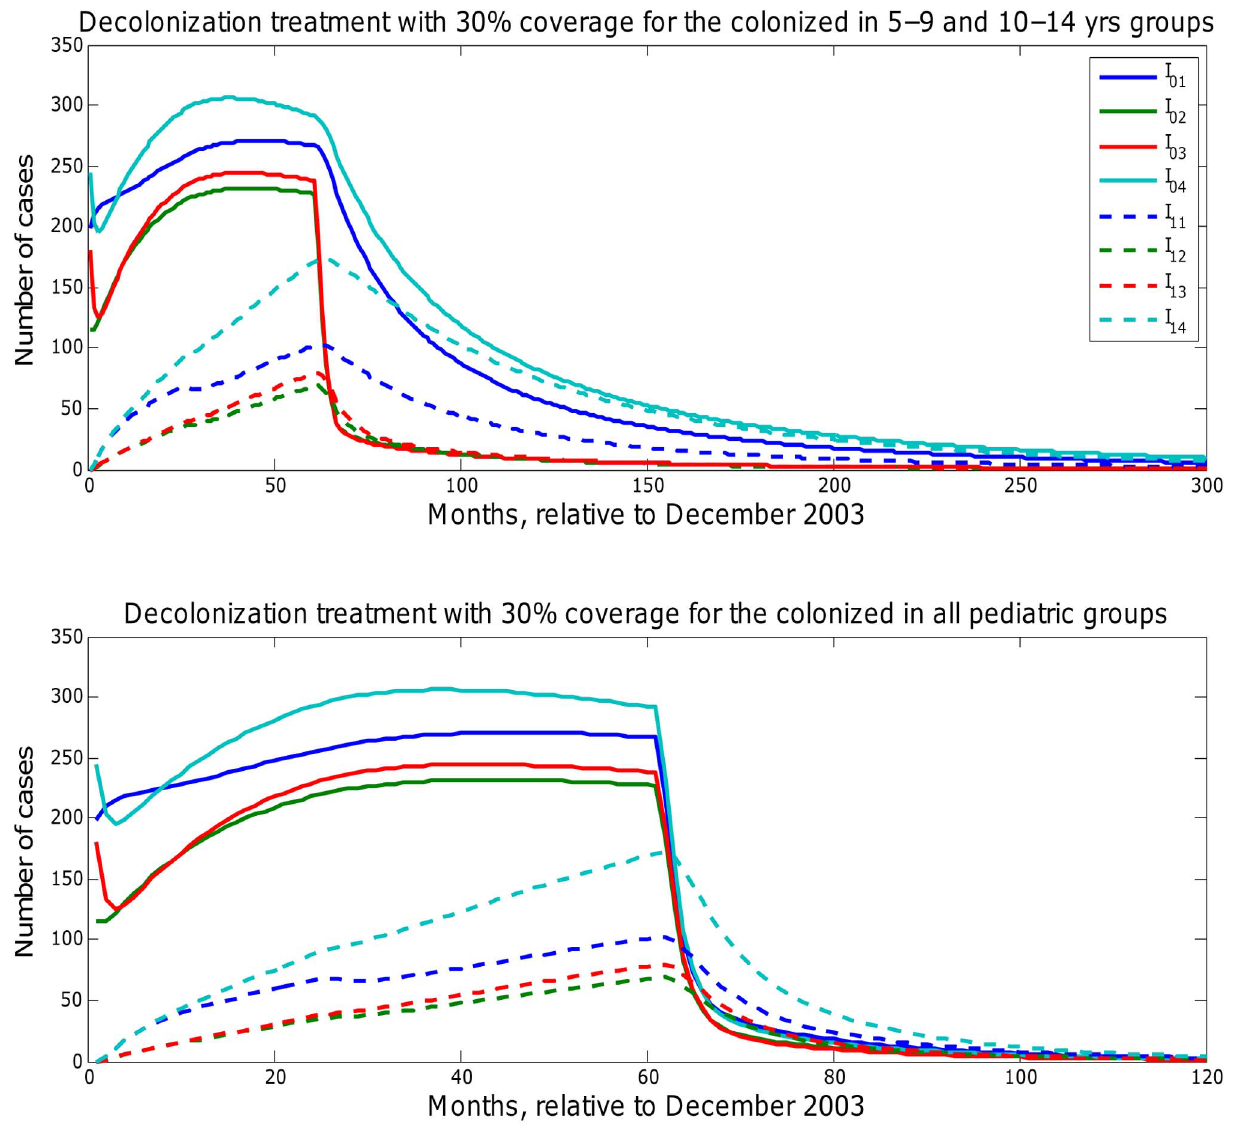
Figure 9. Long-term forecast of CA-MRSA infections in the pediatric groups under decolonization treatment strategy targeting colonized people with 30% coverage in different age groups. 5–9 and 10–14 yrs. age groups (upper panel); all pediatric groups (lower